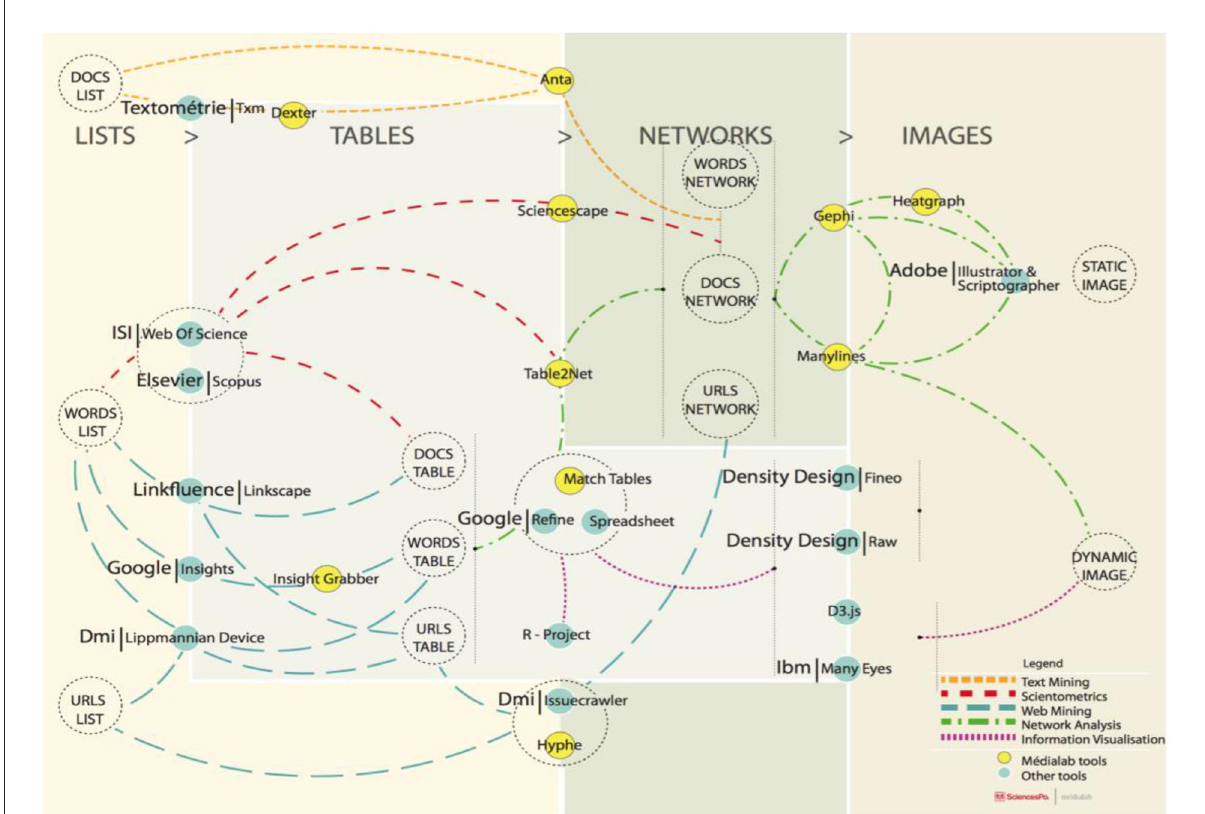
FIGURE3 Diagram of network research processes using digital methods, designed at the médialab (Sciences Po), and presented at the MiniVAN workshop in London. The diagram shows different kinds of research tools, objects, and processes in research activities of the